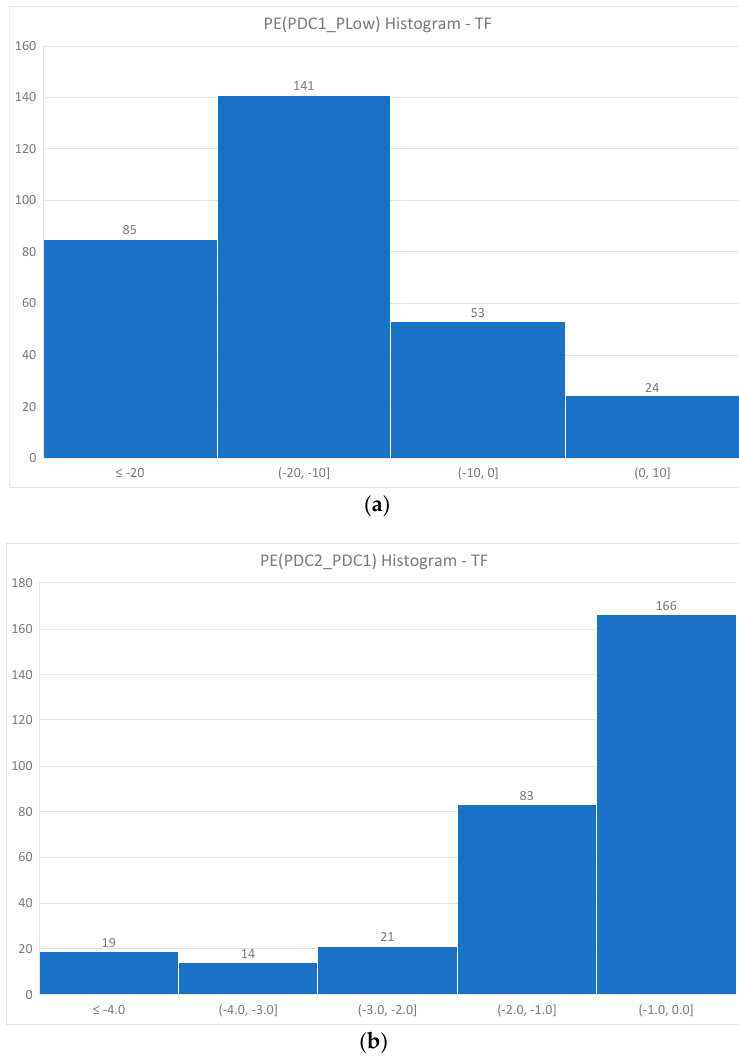
Figure 9. Histograms of the Percentage Error 𝑃𝐸 (cid:2869)(cid:3013)(cid:3042)(cid:3050) concerning 𝑃𝐷𝐶 (cid:2869)(cid:3013)(cid:3042)(cid:3050) and 𝑃 (cid:3013)(cid:3042)(cid:3050) ( a ), and the Percentage Error 𝑃𝐸 (cid:2870)(cid:3013)(cid:3042)(cid:3050) concerning 𝑃𝐷𝐶 (cid:2870)(cid:3013)(cid:3042)(cid:3050) and 𝑃𝐷𝐶 (cid:2869)(cid:3015)(cid:3016)(cid:3004) ( b ); thin-films modules. The Mean Absolute Percentage Error ( 𝑀𝐴𝑃𝐸) results concerning monocrystalline, polycrystalline, and thin films under Low-Irradiance Conditions are shown in Table 3. Table 3. 𝑀𝐴𝑃𝐸 for monocrystalline, polycrystalline, and thin-films modules, under Low-Irradi- ance Conditions ( Low ). 𝑀𝐴𝑃𝐸 (cid:2869)(cid:3013)(cid:3042)(cid:3050) relates to the error between 𝑃𝐷𝐶 (cid:2869)(cid:3013)(cid:3042)(cid:3050) and 𝑃 (cid:3013)(cid:3042)(cid:3050) , 𝑀𝐴𝑃𝐸 (cid:2870)(cid:3013)(cid:3042)(cid:3050) re- lates to the error between 𝑃𝐷𝐶 (cid:2870)(cid:3013)(cid:3042)(cid:3050) and 𝑃𝐷𝐶 (cid:2869)(cid:3013)(cid:3042)(cid:3050) and 𝑀𝐴𝑃𝐸 (cid:2871)(cid:3013)(cid:3042)(cid:3050) relates to the error between